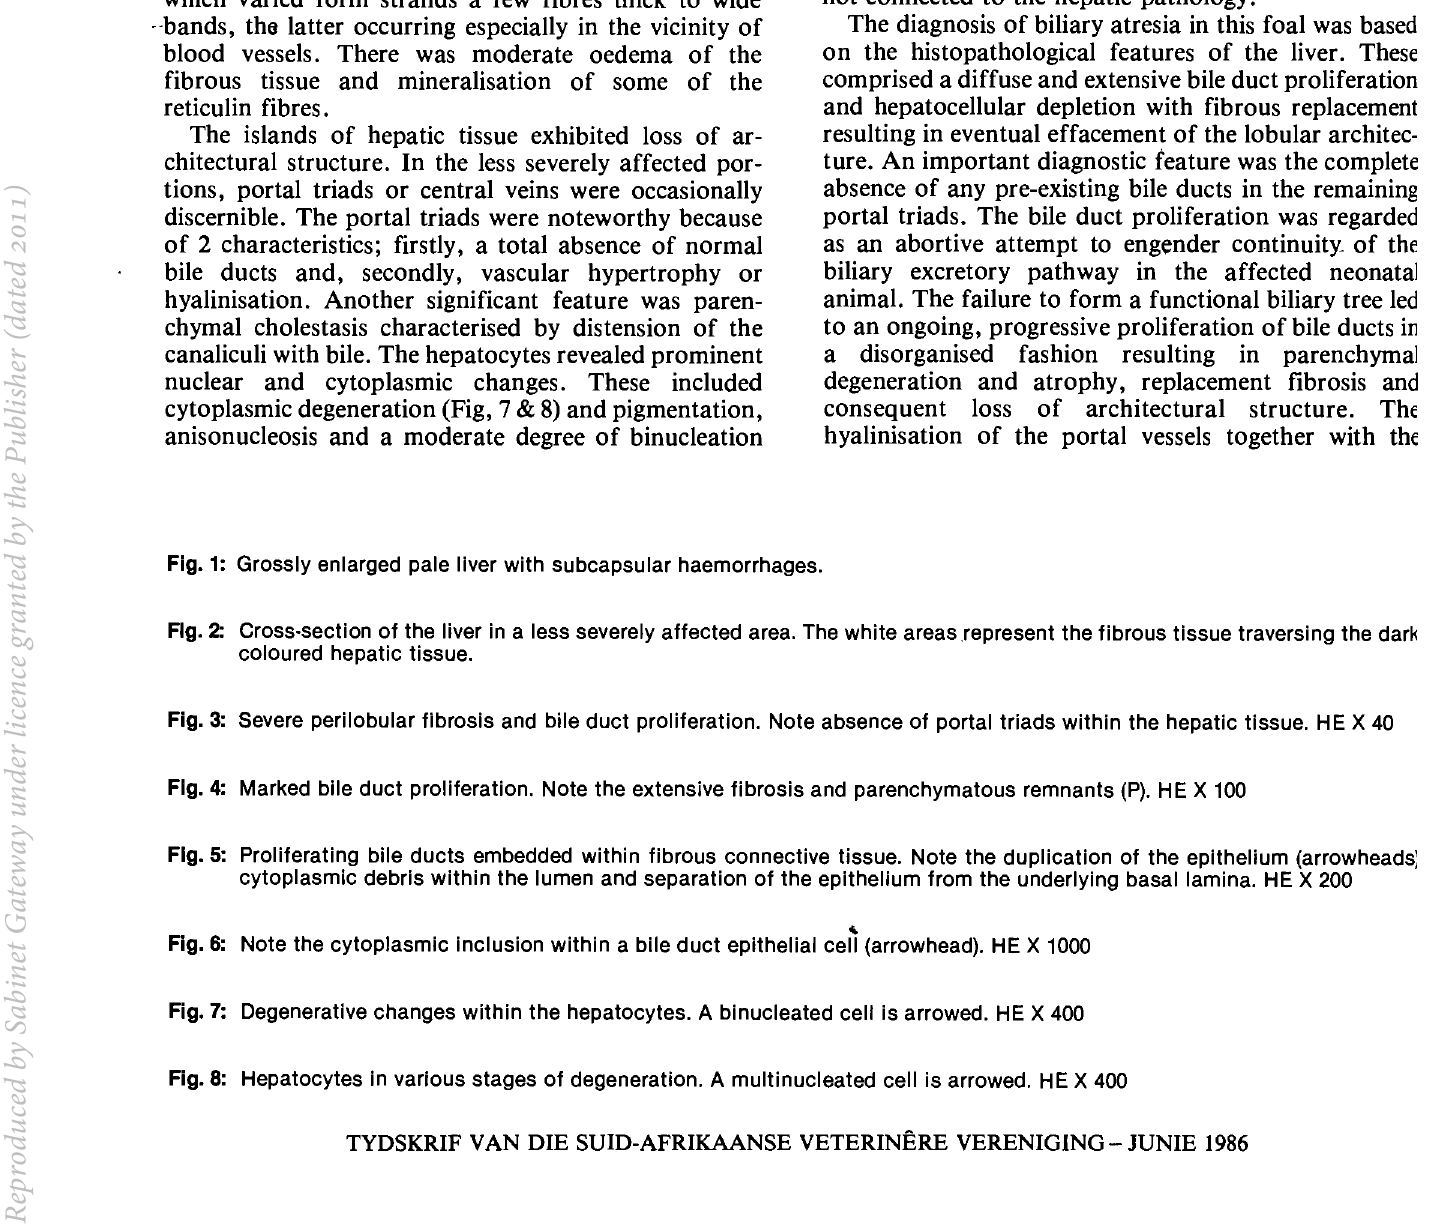
Fig. 1: Grossly enlarged pale liver with subcapsular haemorrhages. Flg.2: Cross-section of the liver in a less severely affected area. The white areas represent the fibrous tissue traversing the dark coloured hepatic tissue. Fig. 3: Severe peri lobular fibrosis and bile duct proliferation. Note absence of portal triads within the hepatic tissue. HE X 40 Fig. 4: Marked bile duct proliferation. Note the extensive fibrosis and parenchymatous remnants (P). HE X 100 Flg.5: Proliferating bile ducts embedded within fibrous connective tissue. Note the duplication of the epithelium (arrowheads: cytoplasmic debris within the lumen and separation of the epithelium from the underlying basal lamina. HE X 200 .. Fig. 6: Note the cytoplasmic inclusion within a bile duct epithelial cell (arrowhead). HE X 1000 Fig. 7: Degenerative changes within the hepatocytes. A binucleated cell is arrowed. HE X 400 Fig. 8: Hepatocytes in various stages of degeneration. A multinucleated cell is arrowed. HE X 400 TYDSKRIF VAN DIE SUID-AFRIKAANSE VETERINERE VERENIGING-JUNIE